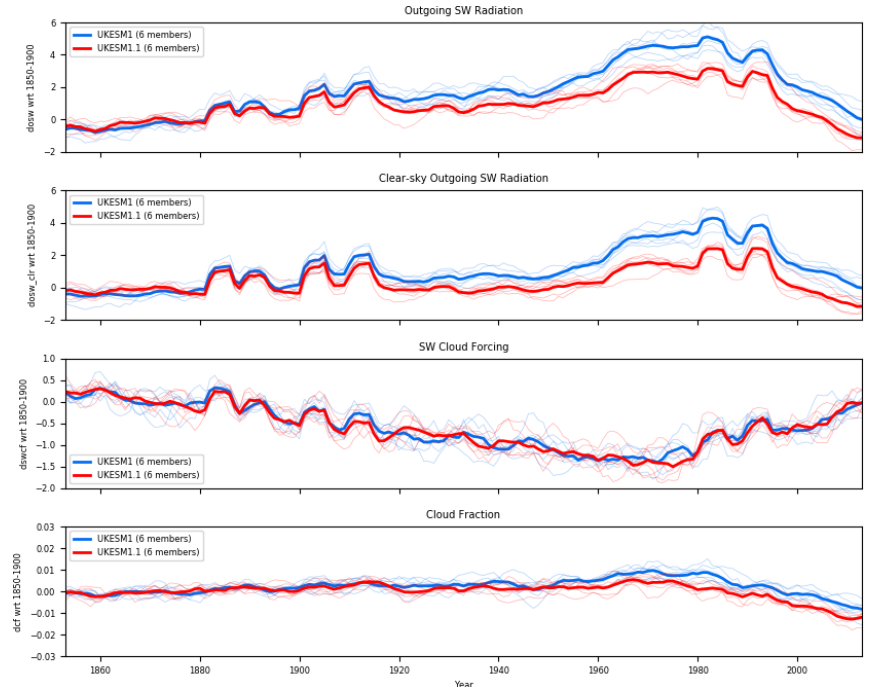
Figure 7. Historical evolution of anomalies in all-sky and clear-sky outgoing SW radiation, SW cloud forcing and cloud fraction relative to the 1850–1900 mean in UKESM1 (blue) and UKESM1.1 (red). Both the ensemble mean (thick lines) and individual ensemble members (fainter lines) are plotted. A 5-year running mean has been applied to the annual mean model output.